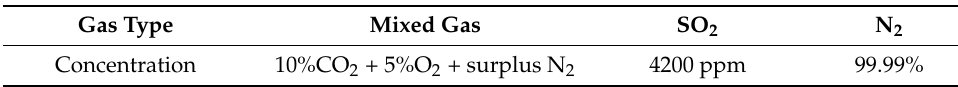
Figure 4. Schematic diagram of experimental system. Table 2. Gas composition and flow